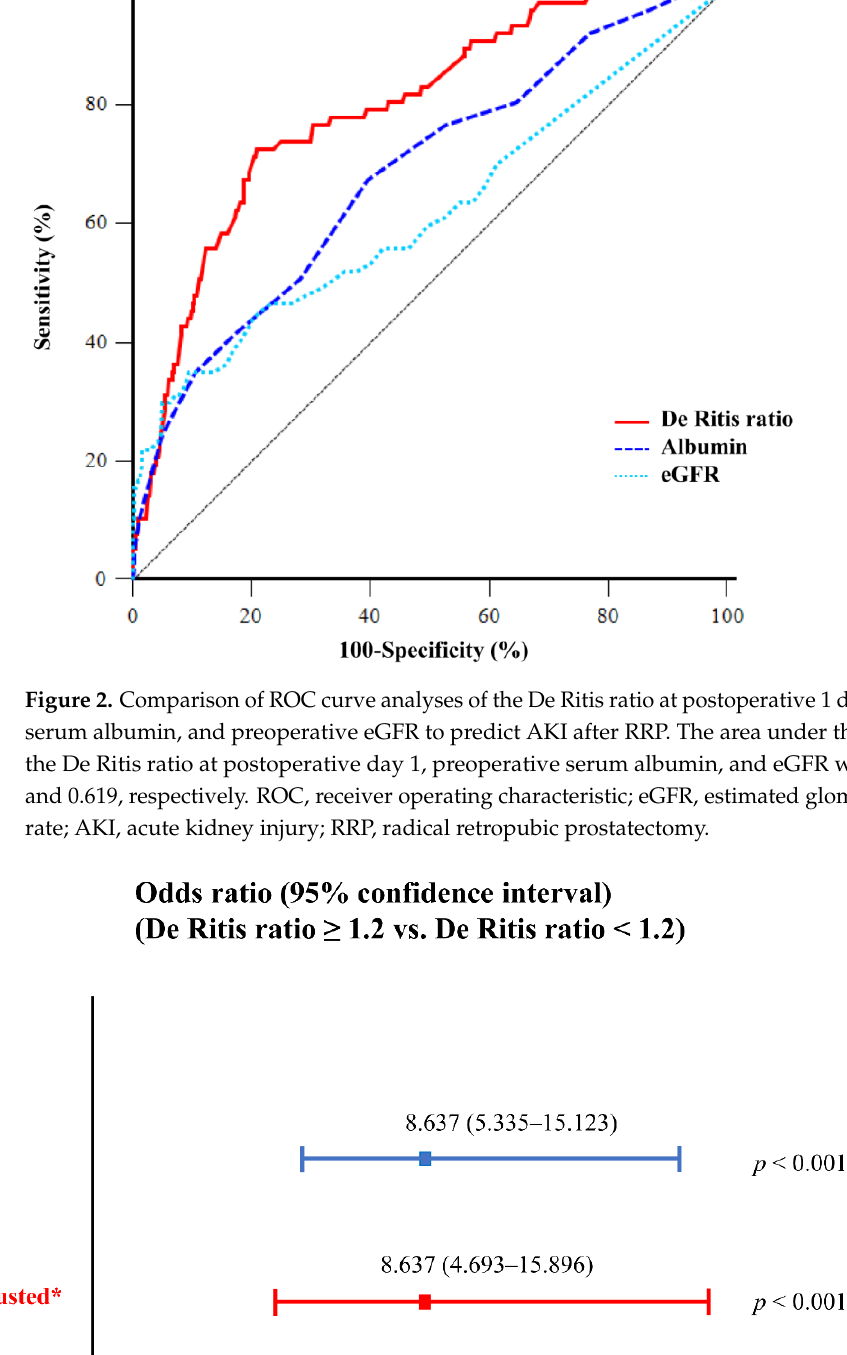
Table 4. Postoperative outcomes.